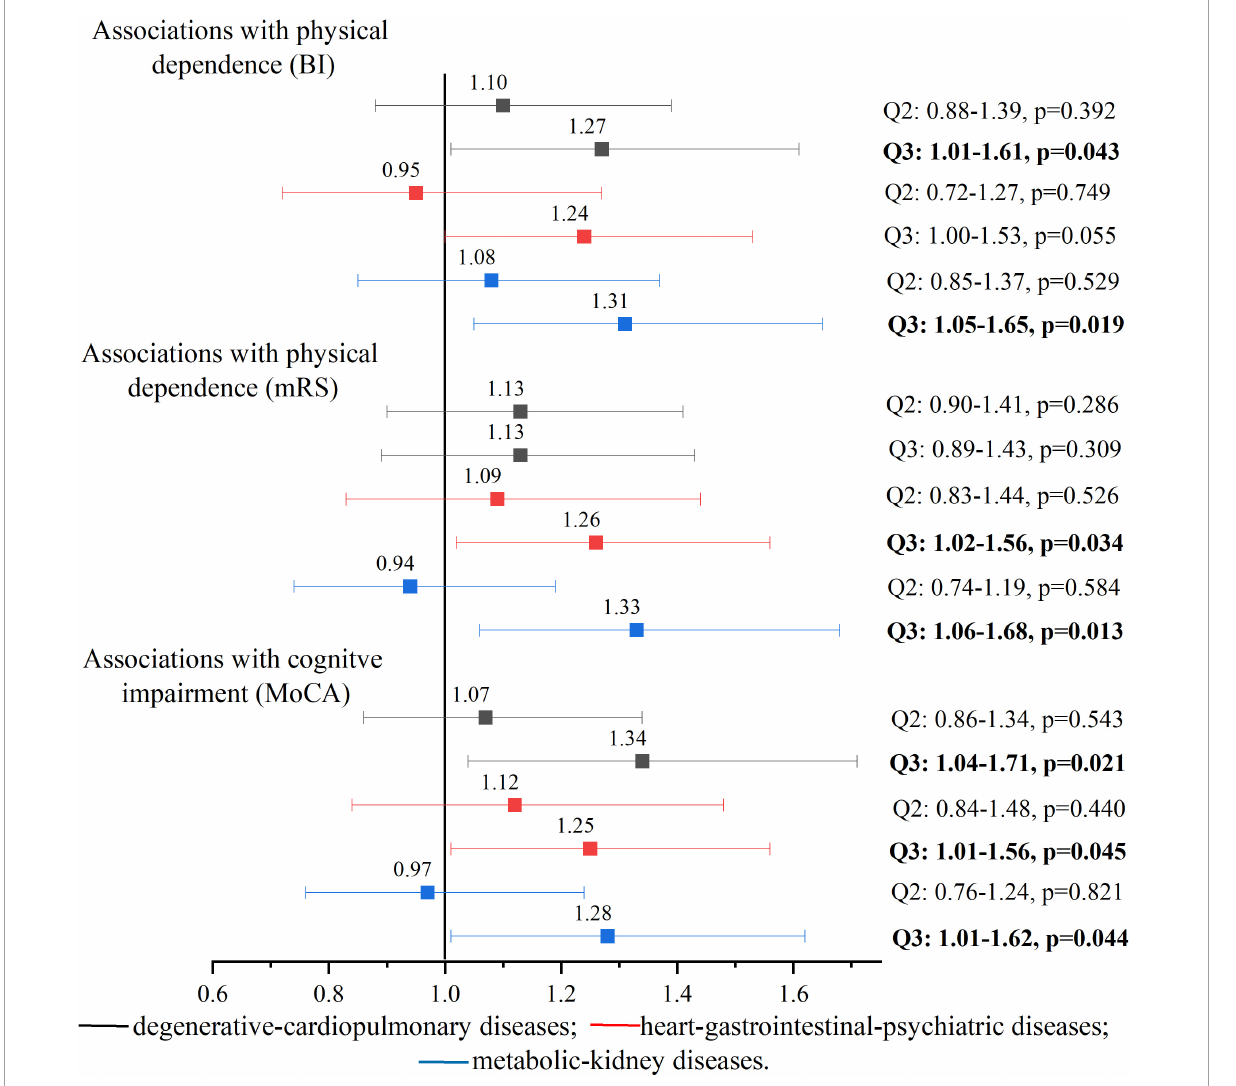
FIGURE2 Associations between comorbidity patterns and functional outcomes among patients with first-ever ischemic stroke. Odds ratios and 95% confidence intervals were adjusted for age, sex, education, marital status, type of health insurance, enrolled hospital, type of stroke, smoking status, alcohol drinking, and difficulties in falling asleep. The lower tertile (Q1) was used as the reference group; Q2: the medium tertile; Q3: the upper tertile. Missing data were dealt with multiple imputation and the RVI for multiple logistic regression models ranged from 0.0298 to